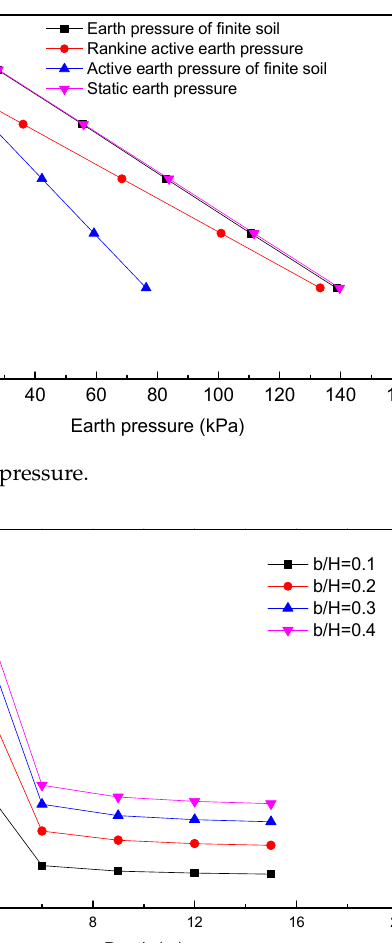
Figure 10. Influence of width-to-depth ratio on η .